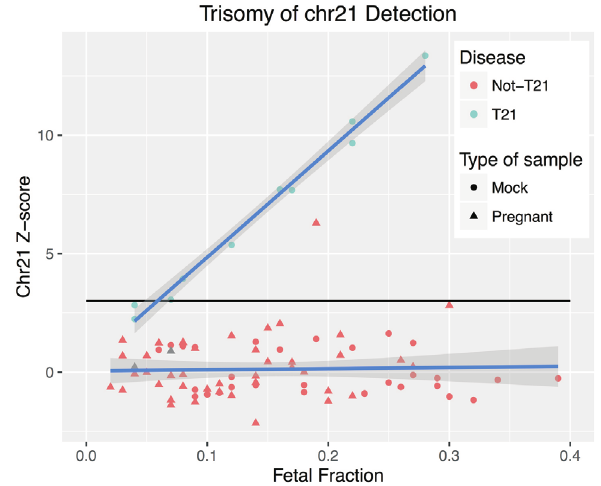
Figure 4 - T21 detection. Chromosome 21 Z-score as function of FF. Color and shape incorporate both disease status (blue = T21, red = Not-T21 samples) and type of sample (circle = mock, triangle= samples with pregnant women), which represents 10 T21 samples (all mock), and 73 non-T21 samples (30 mock and 43 pregnant).